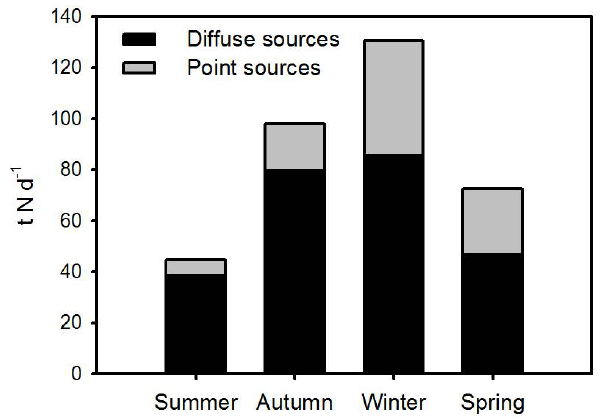
Fig. 4. Contribution of diffuse and point sources to nitrate loads in the Oglio River, calculated in the period